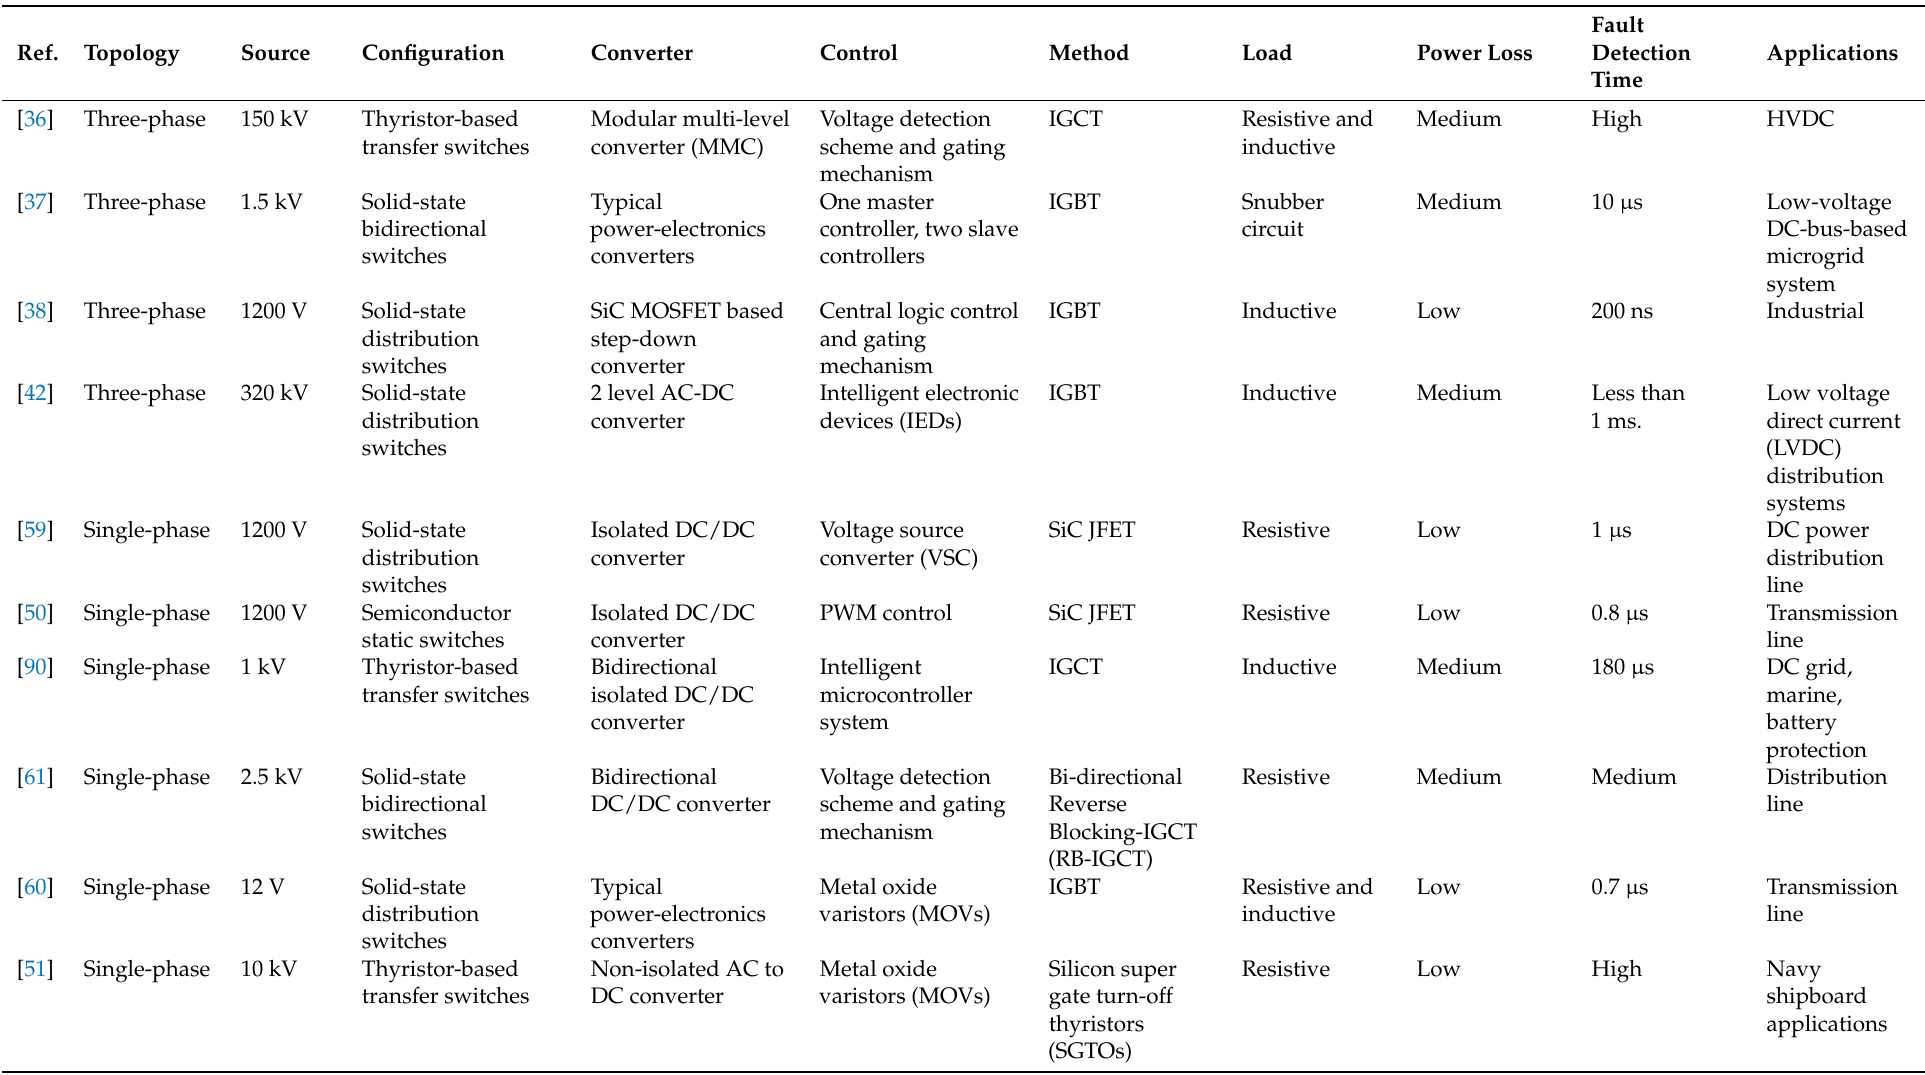
Table 3. Detailed technical comparative analysis of top 10 cited